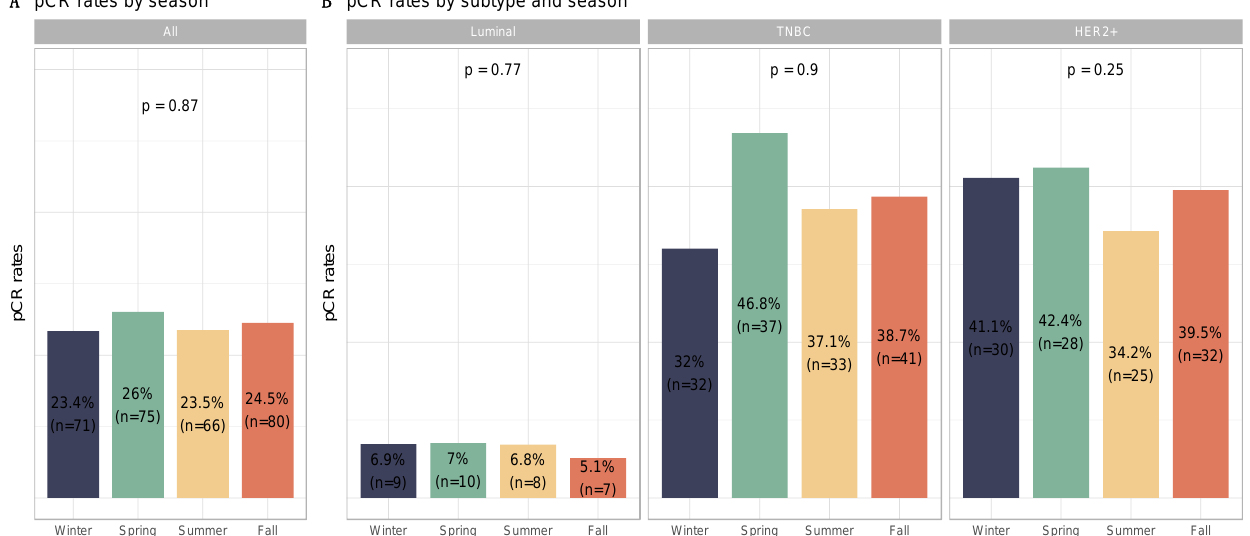
Figure 3. Barplots for associations between response to treatment and season at breast cancer diag- nosis in the whole population and by breast cancer subtype: ( A ) among the whole population, All (n = 1193) (Winter (n = 303), Spring (n = 287), Summer (n = 279), Fall (n = 324)); ( B ) by BC subtype, Luminal (n = 526) (Winter (n = 103), Spring (n = 142), Summer (n = 117), Fall (n = 137)); TNBC (n = 374) (Winter (n = 100), Spring (n = 79), Summer (n = 89), Fall (n = 106)); HER2 (n = 293) (Winter (n = 73), Spring (n = 66), Summer (n = 73), Fall (n =